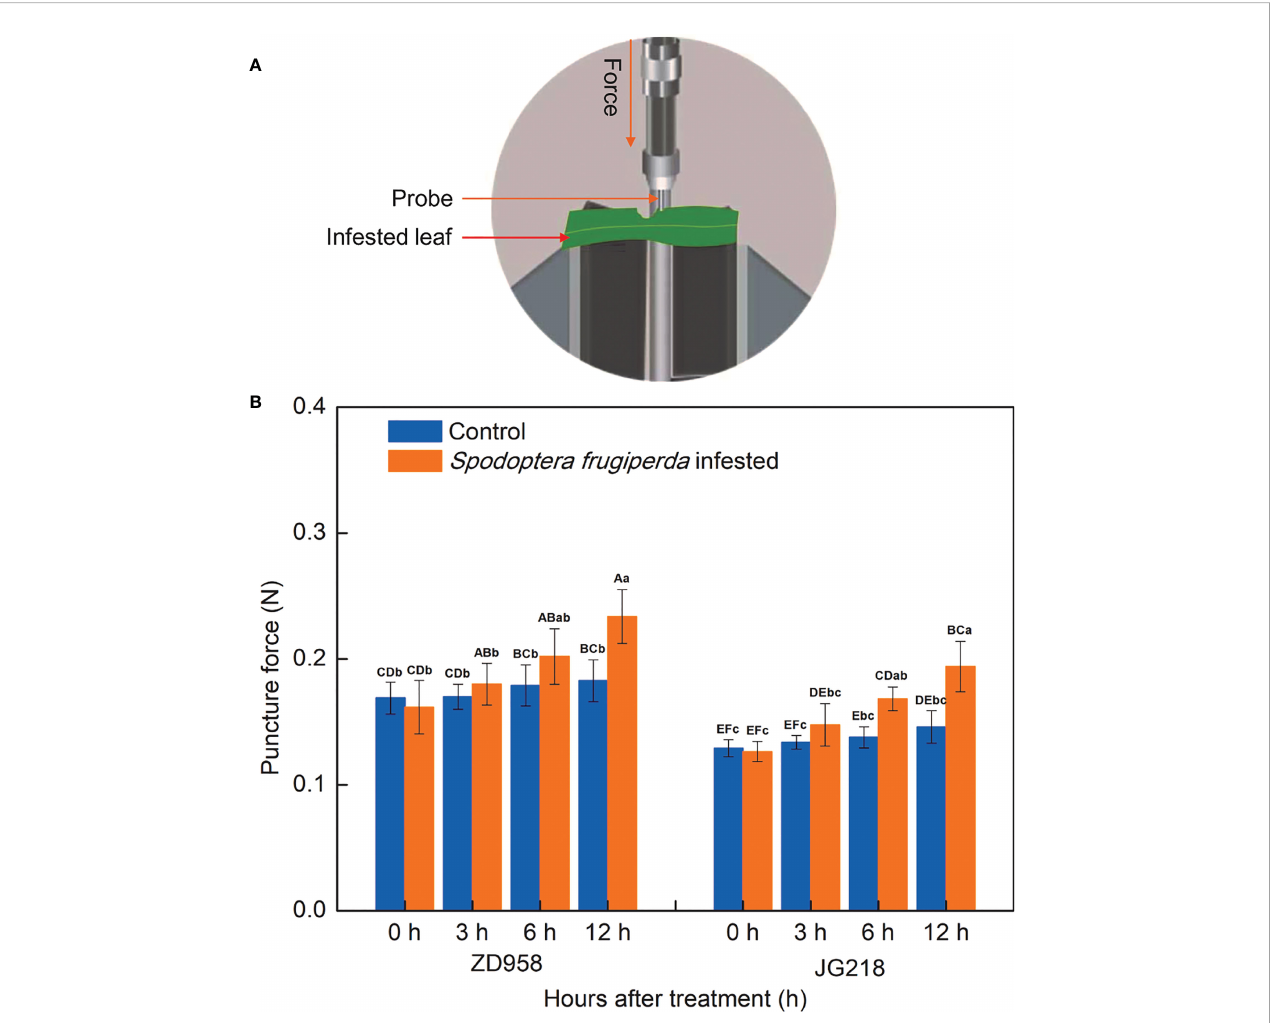
FIGURE 3 Effect of S. frugiperda infestation on puncture force levels in maize leaves. (A) Force needed to puncture the leaf. (B) Puncture force levels. Data are shown as means ± SD ( n = 3, every n represents the mean of three pieces of each of the middle region of the second and third leaf, respectively). Different letters indicate signi fi cant differences at P < 0.05. Capital letters represent differences between the two maize cultivars, while lowercase letters indicate differences between treatments within the same